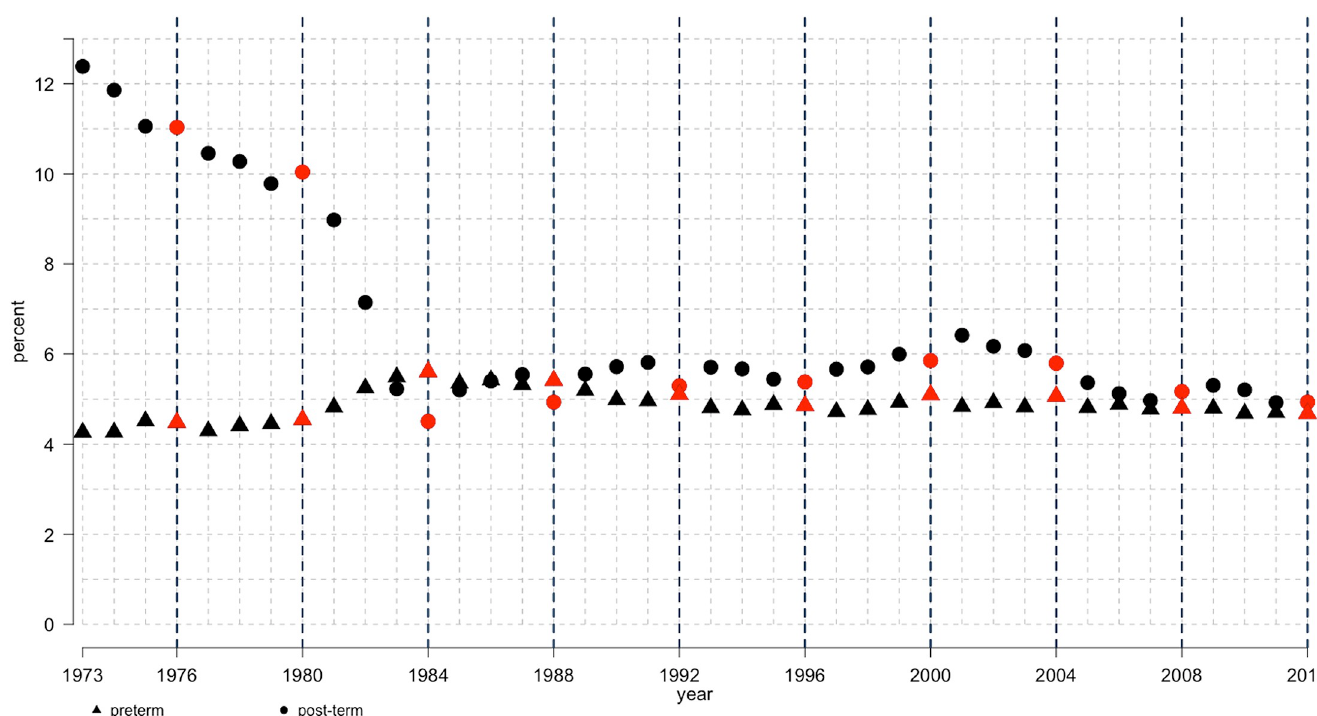
Fig 2. Incidence of preterm and post-term deliveries, Swedish Medical Birth Register, 1973–2012. Percentages of preterm (triangle) and post-term (circle) deliveries registered from 1973 to 2012. Red dots and vertical black dashed line marks leap years. Preterm and post-term deliveries defined as pregnancies lasting < 259 days and > 294 days, respectively. Sample size: n = 3 940